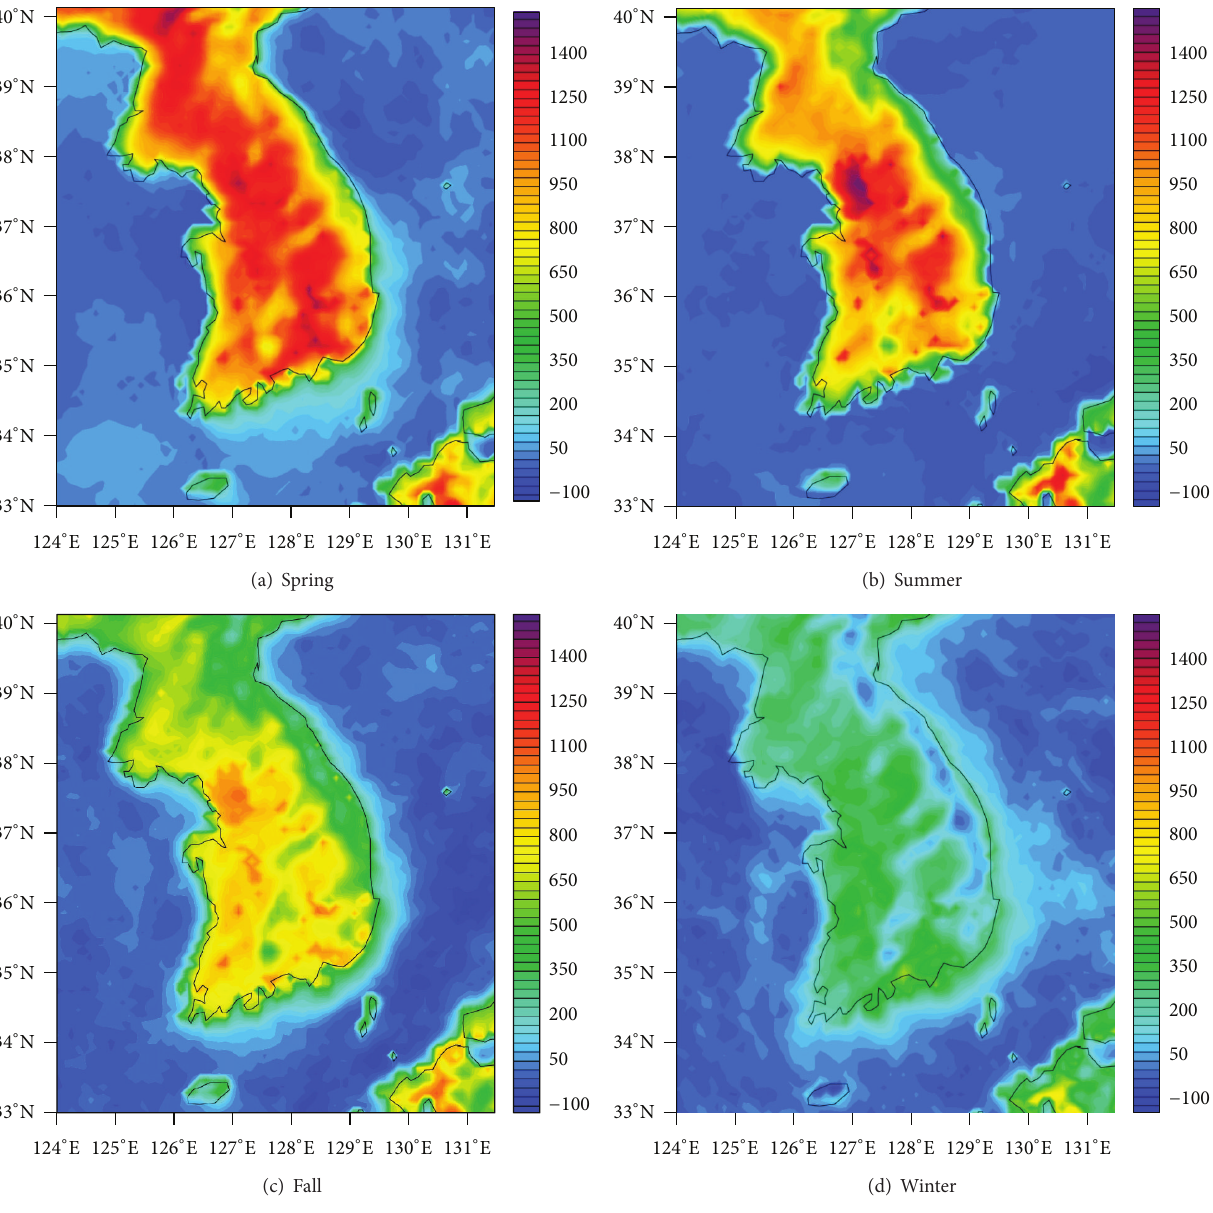
Figure 6: Seasonal mean distributions of the diurnal range of PBLH over the Southern Korean Peninsula and surrounding ocean during the period June 2010–May